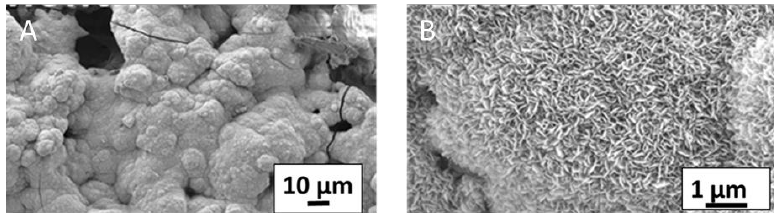
Figure 6. SEM images of zein/HA coatings after treatment in SBF for 3 days. ( A ) Low magnification and ( B ) higher magnification.